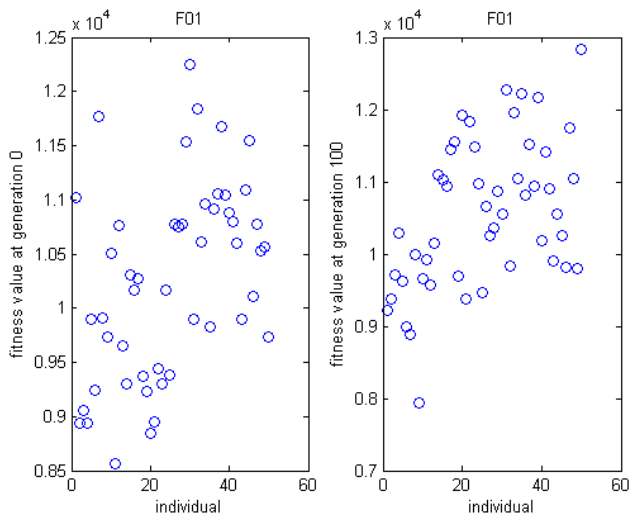
Figure 10. The distribution graph of fitness on MSO4 for F01.